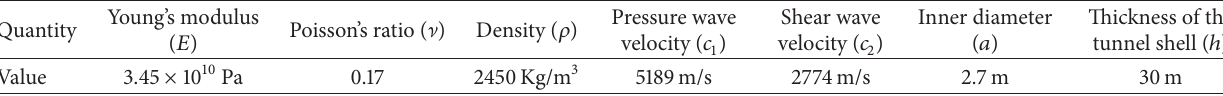
Table 3: The parameters for the tunnel segments.